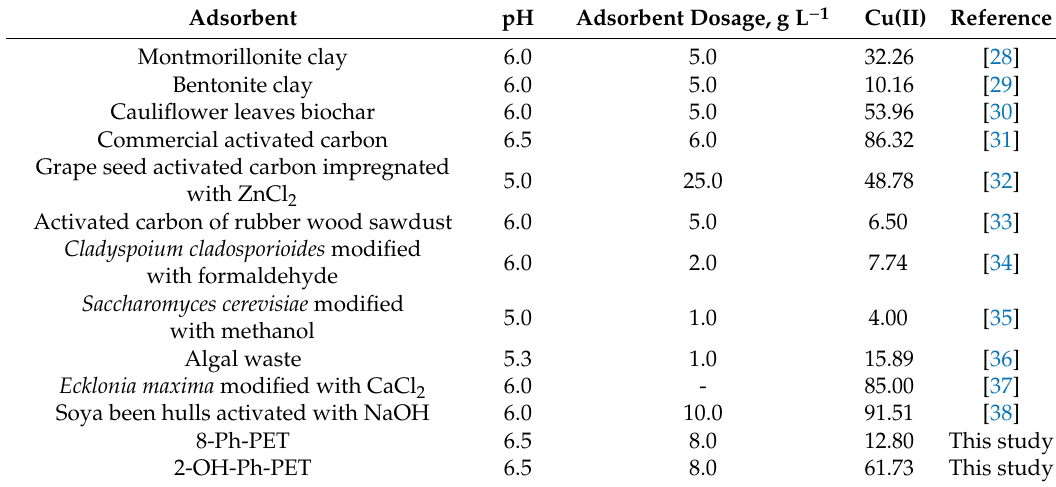
Table 2. Maximum adsorption capacity obtained for the removal of Cu(II) ions from aqueous media using these two materials (8-Ph-PET and 2-OH-Ph-PET) and other adsorbents.